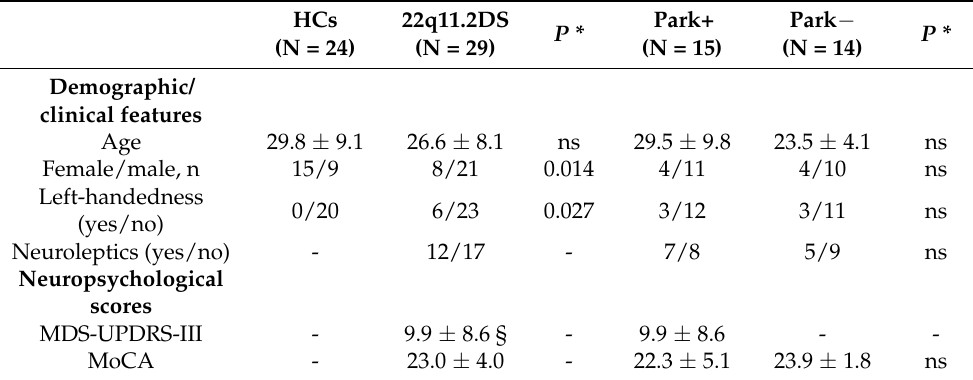
Table 1. Demographic and clinical characteristics of healthy controls (HCs) and patients with 22q11.2 deletion syndrome (22q11DS) with and without parkinsonism (Park+ and Park − ). Values are reported as the mean ± standard deviation; n, number; y, years; ns, not statistically significant. HCs